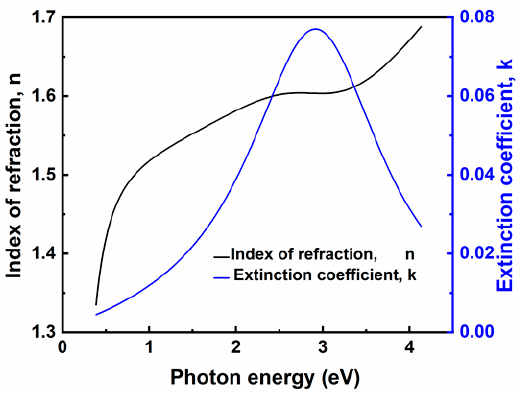
Figure 9. Estimated dispersion laws estimated of reduced graphene oxide stabilized with poly(sodium 4-styrenesulfonate) on SiO 2 / Si substrates by ellipsometry characterization. The curves represent the index of refraction (black lines) and the extinction coefficient (blue lines).